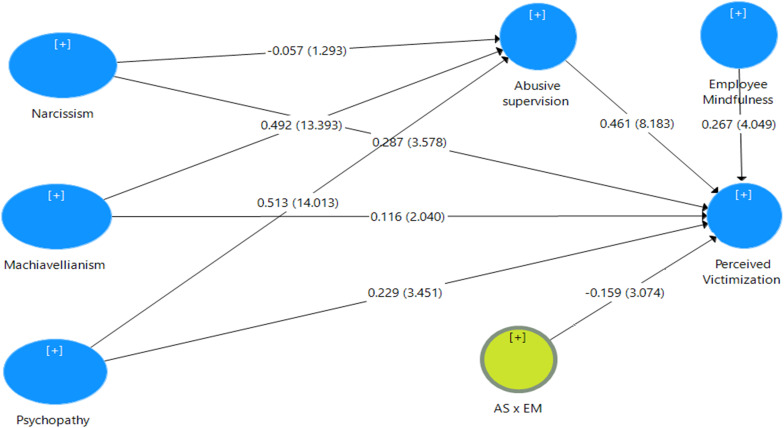
Structural model for Moderation paths.